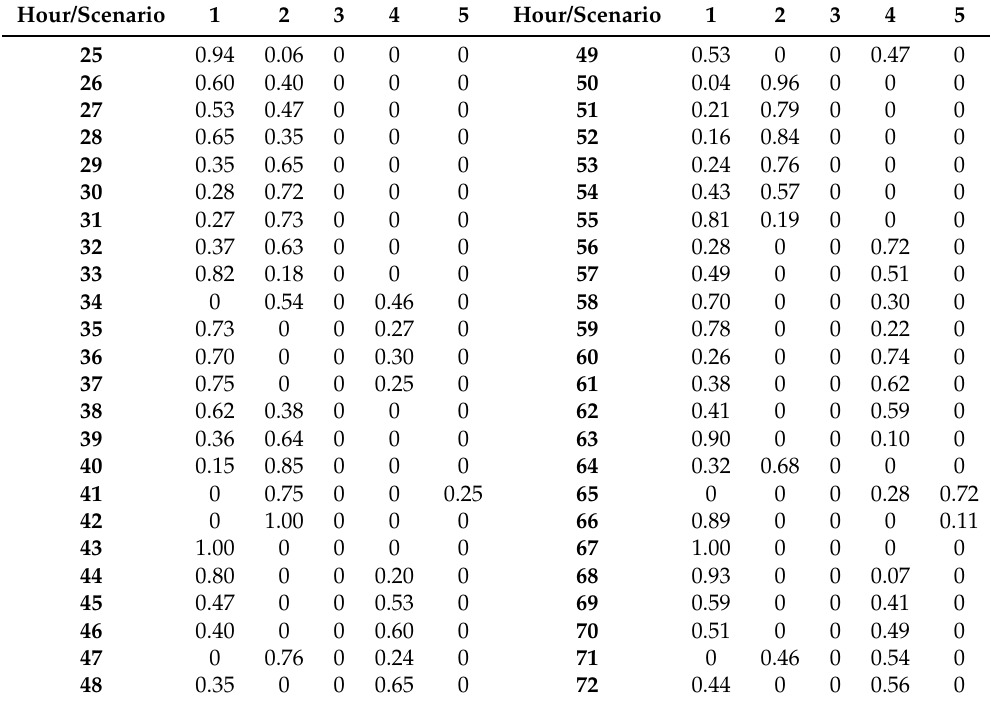
Table 6. β ∈ [ 0,1 ] values in each scenario of the forecasted price for the second and third days of the